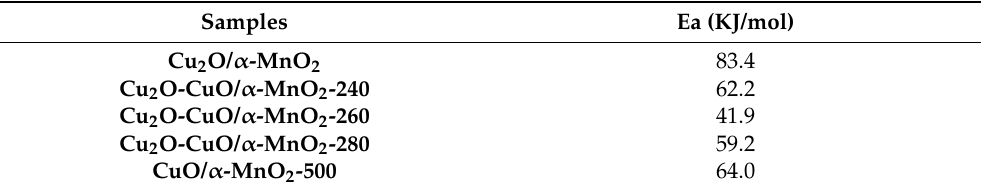
Figure 3. Arrhenius plots for the CO oxidation reaction rate over the as-prepared Cu 2 O/ α -MnO 2 , Cu 2 O-CuO/ α -MnO 2 -T, and CuO/ α -MnO 2 -500 catalysts. Table 1. Apparent activation energy data of the as-prepared Cu 2 O/ α -MnO 2 , Cu 2 O-CuO/ α -MnO 2 -T, and CuO/ α -MnO 2 -500 catalysts.